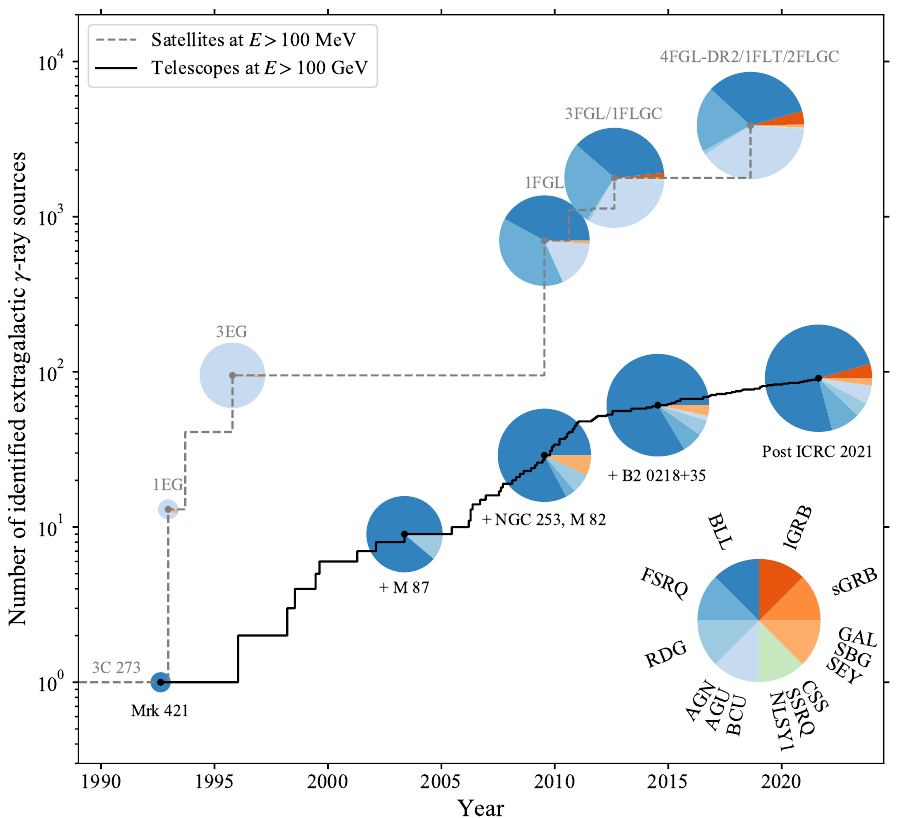
Figure 1. Evolution of the number of extragalactic gamma-ray sources at high energies as a function of time. The extragalactic sources are usually identified as such by matching them with multiwavelength counterparts. The dashed gray line shows significant detections by the EGRET and Fermi -LAT gamma- ray satellites at energies larger than 100 MeV. The pie charts display the distribution of sub-classes of extragalactic sources, as extracted from the 1EG [15], 3EG [10], 1FGL [16], 3FGL [17], 1FLGC [18], 4FGL-DR2 [19], 1FLT [20] and 2FLGC [21] catalogs. The solid black line shows significant detections by gamma-ray telescopes above 100 GeV as extracted from TeVCat [14] after the 2021 international cosmic-ray conference (ICRC 2021). Most of the pre-2005 discoveries were performed at the Whipple observatory while later discoveries essentially came from H.E.S.S., MAGIC and VERITAS. Some of the emblematic ground-based discoveries are indicated under landmark pie charts, featuring the detections of the first blazar Mrk 421 (Whipple), radio galaxy M 87 (HEGRA), starburst galaxies NGC 253 (H.E.S.S.) and M 82 (VERITAS), and gravitationally-lensed blazar B2 0218+35 (MAGIC). The bottom-right pie chart illustrates the categories in which sources are grouped. In blue: BL Lac (BLL: 1307/3866 and 68/91 at E > 100 MeV and E > 100 GeV, respectively, at the time of writing) and flat-spectrum radio quasar (FSRQ: 762/3866 and 8/91) for blazars, radio galaxy (RDG: 46/3866 and 4/91) as their non-aligned counterpart, active galactic nuclei of either radio galaxy of blazar-type with uncertain classification (AGN, AGU, BCU: 1545/3866 and 5/91); in green: the emerging gamma-ray class of narrow-line Seyfert 1, steep-spectrum radio quasars and compact steep spectrum sources (NLSY1, SSRQ, CSS: 17/3866 and 0/91); in orange: regular star-forming galaxies together with starburst galaxies and non-jetted Seyfert-type AGN (GAL, SBG, SEY: 20/3866 and 2/91), gamma-ray bursts of short (sGRB: 14/3866 and 0/91) and long (lGRB: 155/3866 and 4/91)